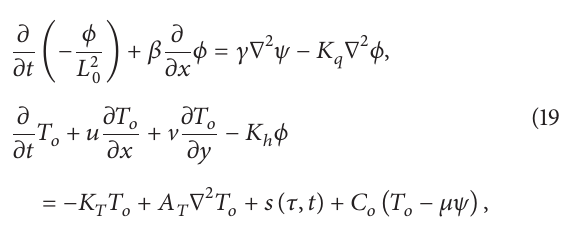
Figure 4: The distribution of 2000 random observations, but removaloftheobservationslocatedintherangeof103 ∘ N ∼ 107 ∘ Nand 35 ∘ E ∼ 40 ∘